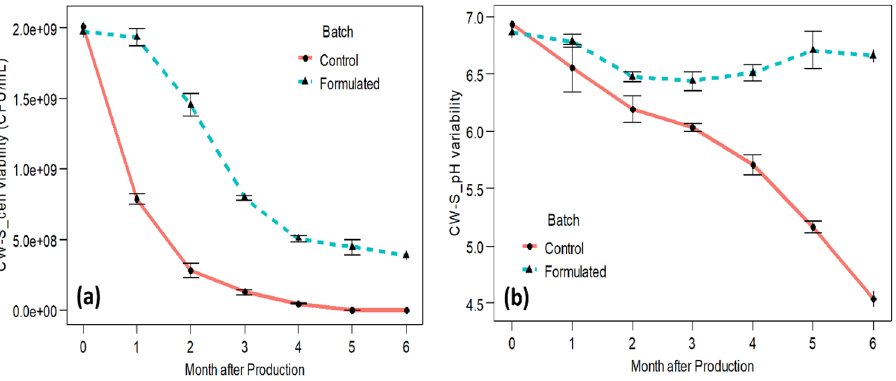
Figure 4. Variation in Bacillus subtilis CW-S cell concentration and pH in the formulation and control over time. ( a ) Viability of cell concentration (CFU/mL). ( b ) Variability in pH.